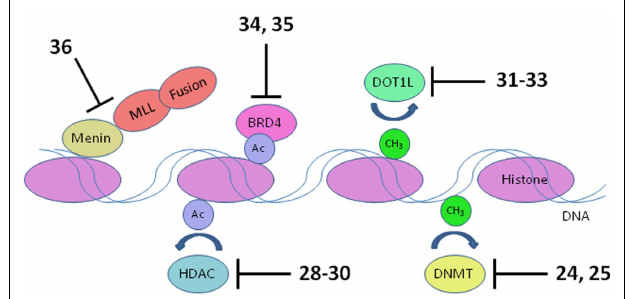
FIGURE 5 |Transcriptional targets . Numerous interconnections between targets and other proteins involved in transcriptional activation are omitted for clarity. HDAC, histone deacetylase; DNMT, DNA methyltransferase. Numbers in bold type refer to inhibitors shown in Figure 3